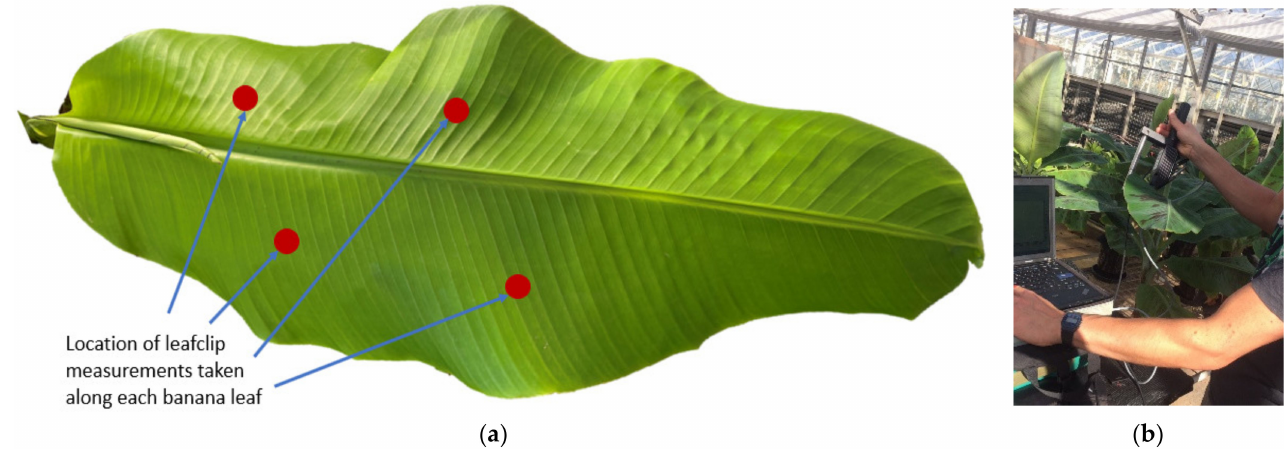
Figure 2. Location of the four hyperspectral leaf clip measurements taken along each leaf ( a ), using an ASD Fieldspec 4 spectrometer fitted with leaf clip accessory to make in situ spectral measurements of banana leaves ( b